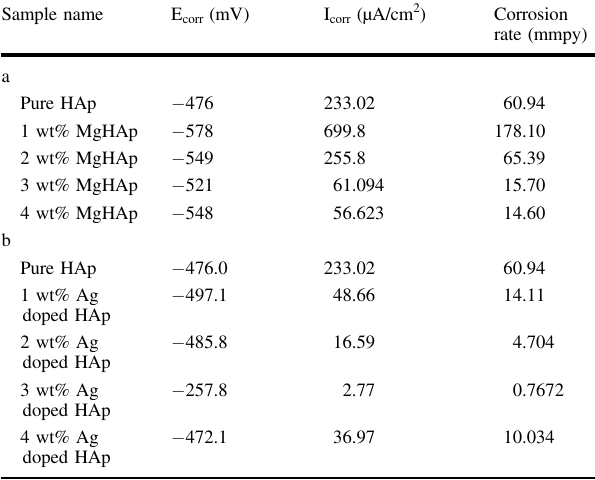
Table 3 a: The corrosion rate of the MgHAp samples as calculated from the Tafel plot. b: The corrosion rate of various AgHAp samples as calculated from the Tafel